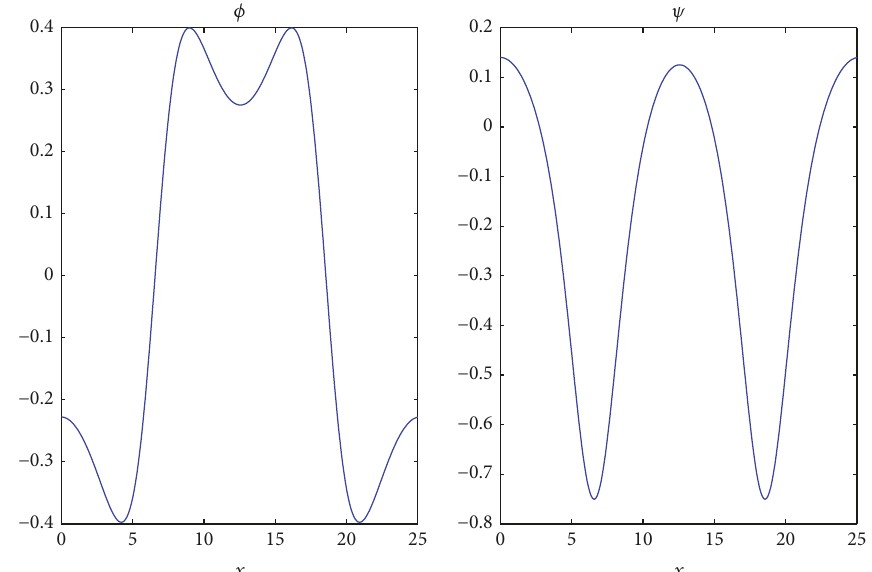
Figure 5: Approximations of the functions 𝜙,𝜓 in the travelling wave solution (39) with 23 Newton’s iterations. The model’s parameters are 𝛼 = 𝛽 = 𝛾 = 1 , 𝑤 = 0.06 , and wave speed 𝑐 = 0.5 and the fundamental period is 𝐿 ≈ 25.13 .